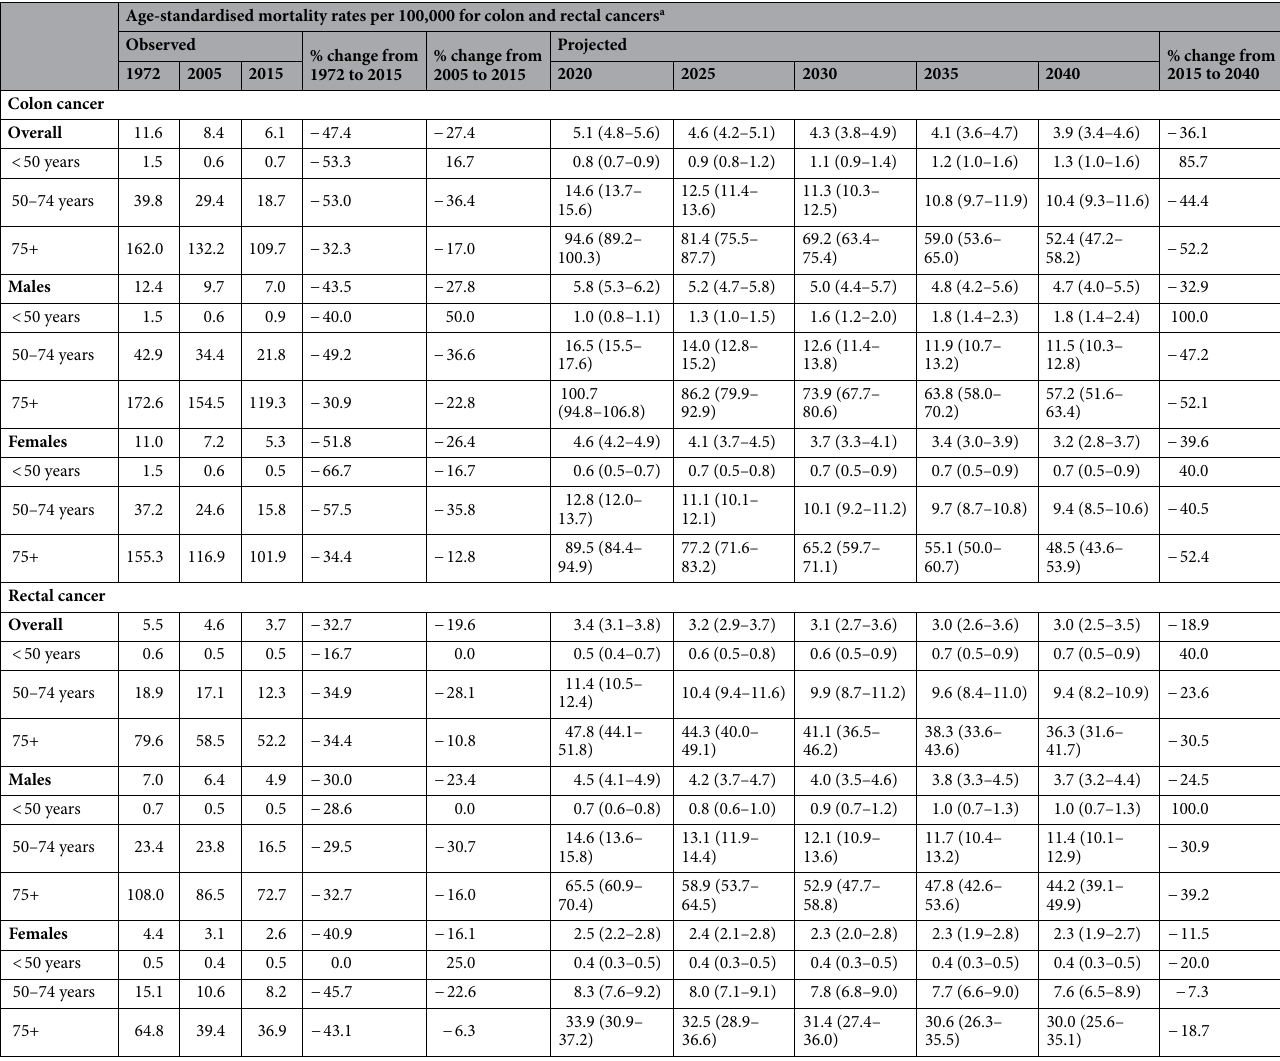
Table 1. Observed and projected age-standardised mortality rates for colon and rectal cancers to 2040 in Australia. a Observed and projected mortality rates were based on the data from the New South Wales Cancer Registry. All rates are age-standardised using the Segi standard